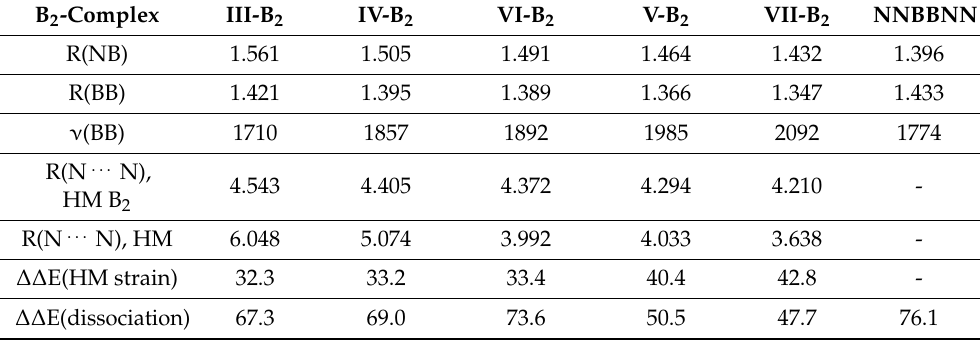
Table 2. Bond distances (N-B and B-B in Å) for the central linear NBBN unit of diboryne complexes III-B 2 -VII-B 2 . Frequencies of the Raman-active B-B stretch (in cm − 1 ). R(N ... N) distances in diboryne complexes III-B 2 -VII-B 2 and corresponding values R(N ... N) for initial host molecules III-VII (N ... N in Å). Strain energy of the host molecules III-VII ∆∆ E(HM strain) (in kcal/mol). ∆∆ E(dissociation) (in kcal/mol) of diboryne adducts III-B 2 –VII-B 2 . Results of the M06-2X/cc-pVDZ